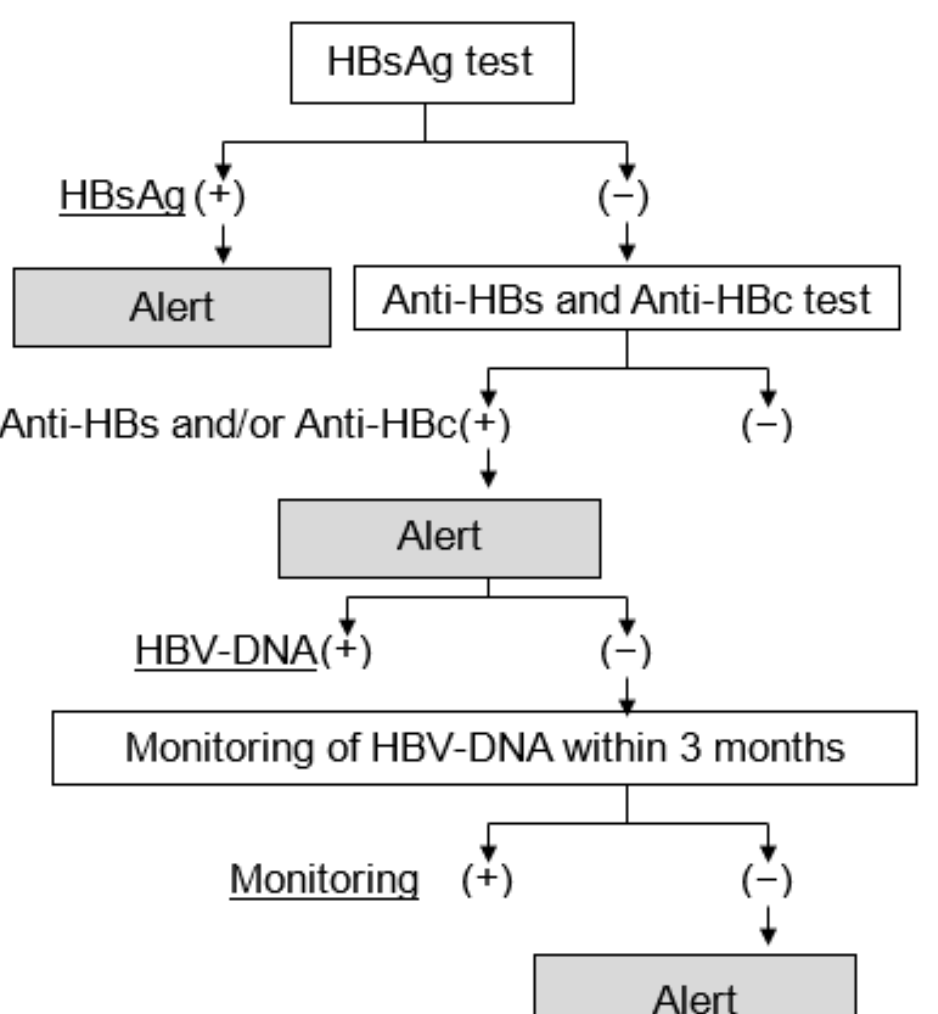
Figure 1. Schematic diagram of the electronic alert system to measure HBV-DNA in HBVr. Abbrevia- tions: HBsAg, hepatitis B surface antigen; anti-HBs, antibody to hepatitis B surface antigen; anti-HBc, antibodies to hepatitis B core antigen; HBV-DNA, hepatitis B virus DNA; HBVr, HBV reac- tivation.